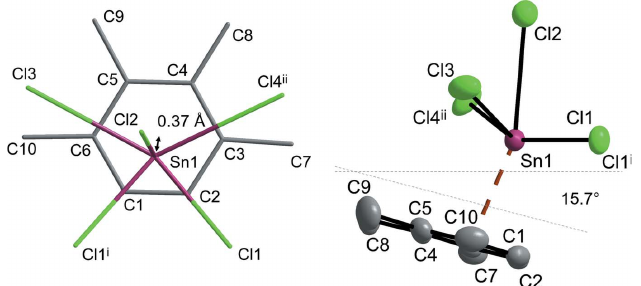
Figure 3 Sn II coordination environment of 1 illustrating the ring slippage (left) and the arene tilt angle (right; displacement ellipsoids drawn at 50% probability level). Symmetry codes: (i) 1 (cid:3) x , (cid:3) y, 1 (cid:3) z ; (ii) 1 (cid:3) x , 1 (cid:3) y , 1 (cid:3) z